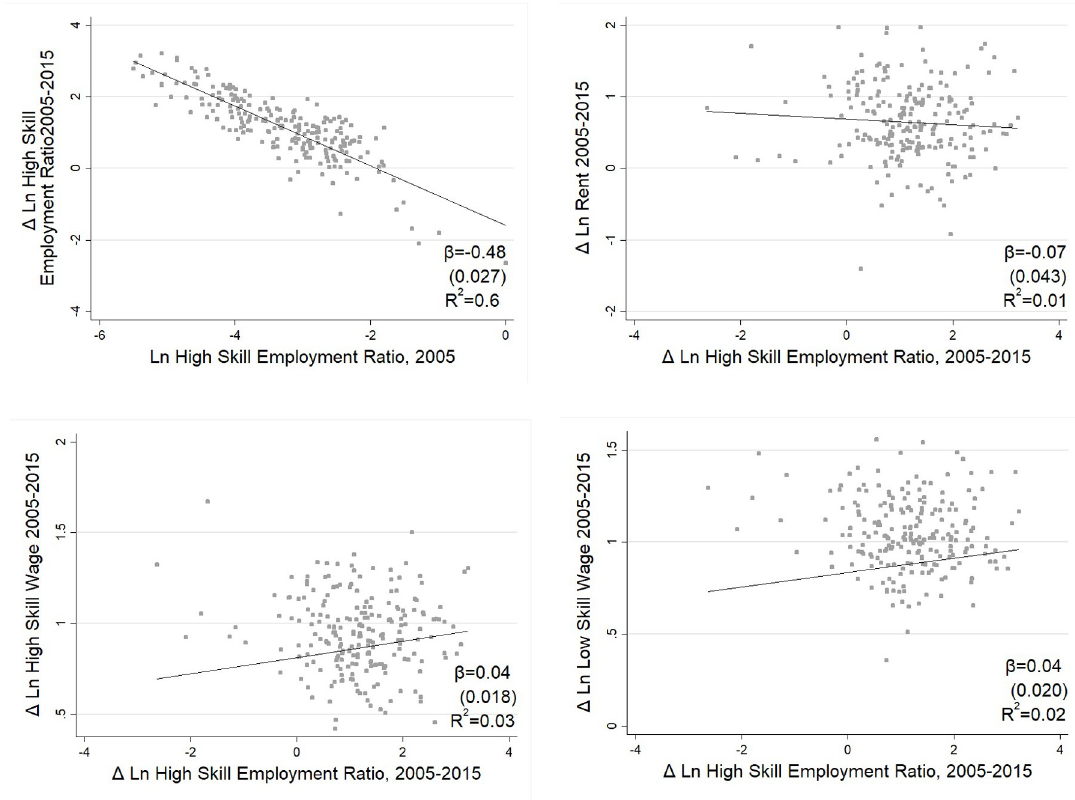
Fig 6. Changes in wages, rents, and high-skill employment ratios from 2005 to